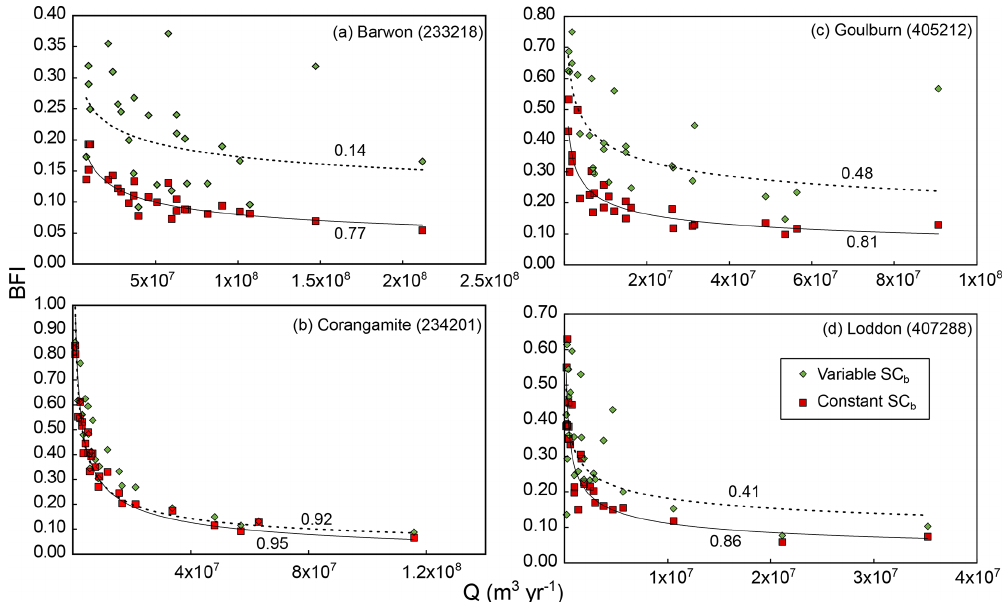
Figure 4. Variation in streamflow ( Q ) and annual BFI calculated from CMB using the variable and constant SC calculations of SC b for one station in the Barwon (a) , Corangamite (b) , Goulburn (c) , and Loddon (d) catchments. Lines are power law fits with R 2 values